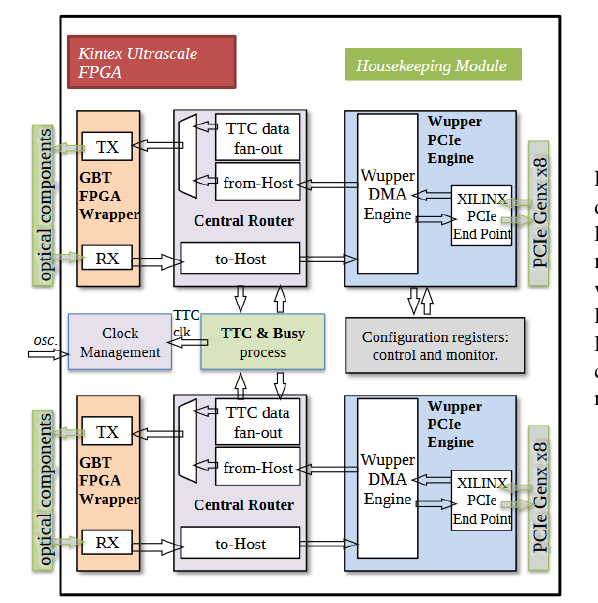
Figure 3. Diagram of the firmware deployed on the FPGA of the FLX-712 in GBT mode. In FULL mode the incoming (RX) GBT link wrapper is replaced with a dedicated FULL mode module. The Central Router is also much simpler in this case, as the data processing requirements are less